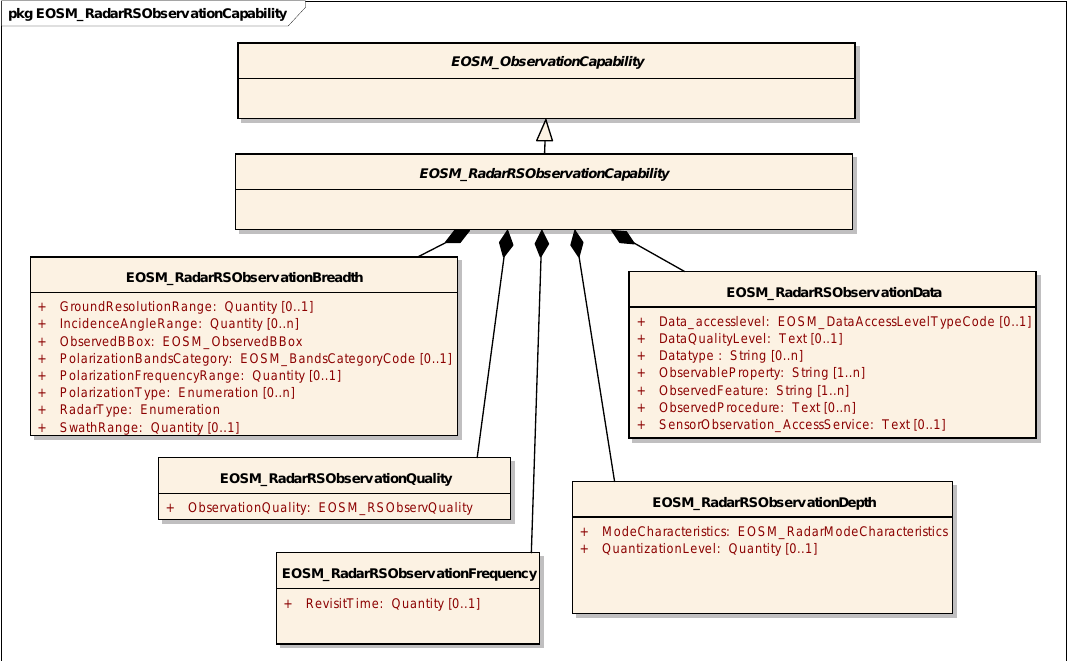
Figure 6. Remote-sensing radar sensor observation capability metadata